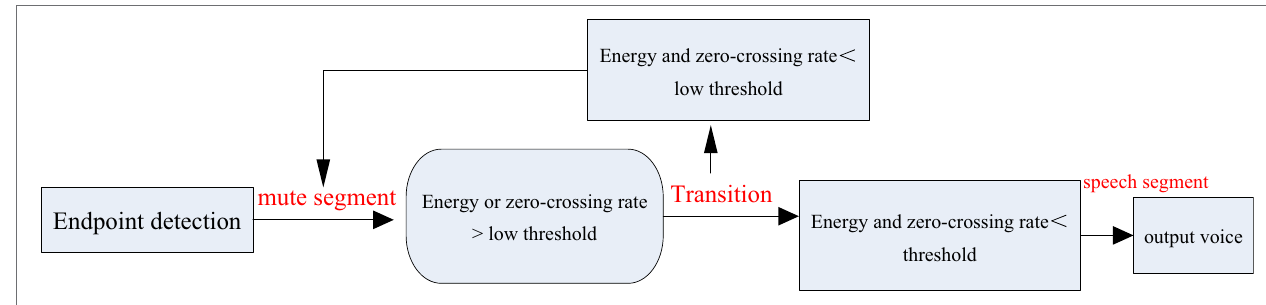
FIGURE 3 | Two-level judgment method for voice